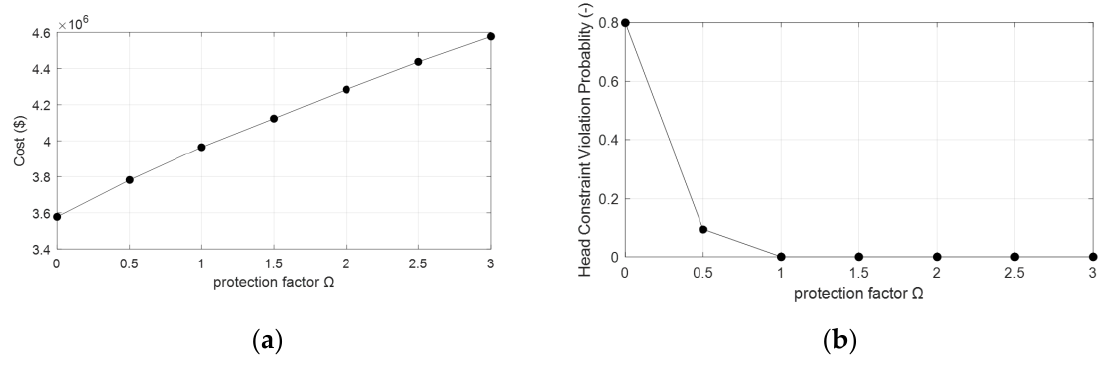
Figure 4. Results of uncorrelated optimization for FOWM network: ( a ) cost vs. protection factor Ω; ( b ) head constraint violation probability.